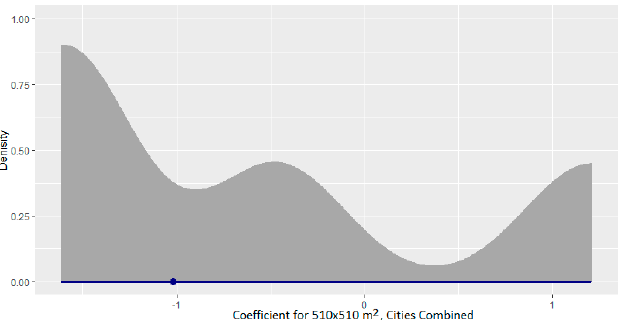
Figure 3. Distribution of the regression coefficient for the impact of morphological density on EUI (posterior, all cities).